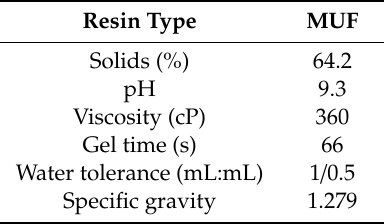
Table 7. MUF resin analysis results, Waferboard.